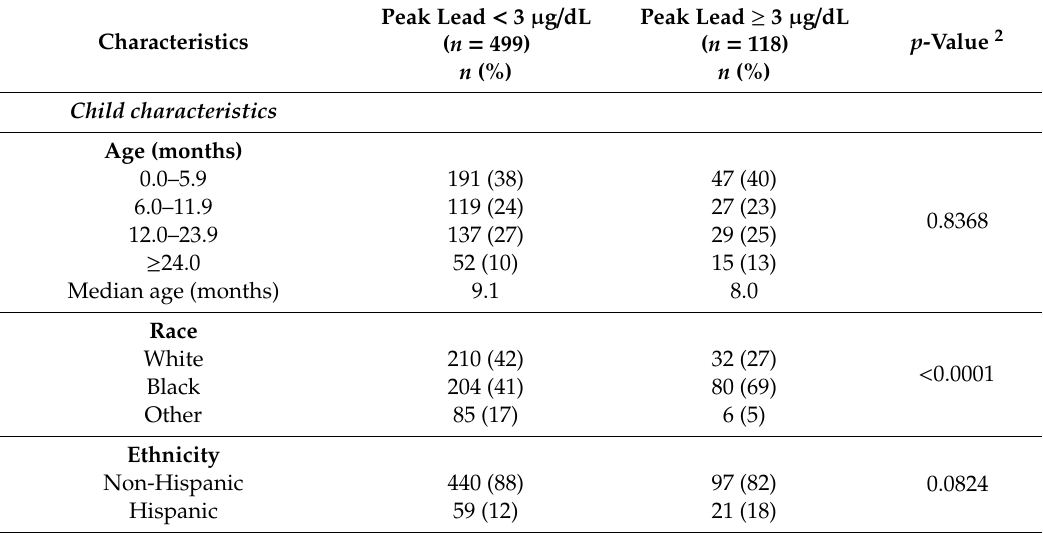
Table 1. Di ff erences in demographic characteristics among children by peak lead values ( n = 617) 1